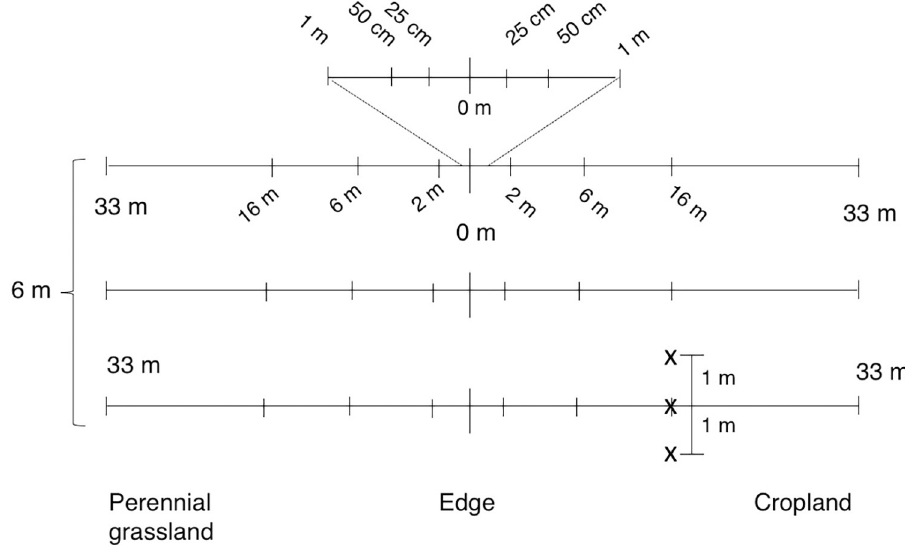
Fig 1. Transect sampling design. Transect sampling design at perennial grassland-annual cropland edges. At each edge site, two per location, three transects (33m from edge into each land use) were spaced 3m apart. Each transect had 15 sampling point locations relative to the edge (25cm-33m). Each sampling point along the transect was randomly assigned to one of three positions (x): 1m left, 1m right or on the transect. At each site, there was a total of 90 sample points (2 sample locations * 3 nested transects * 15 sampling points per